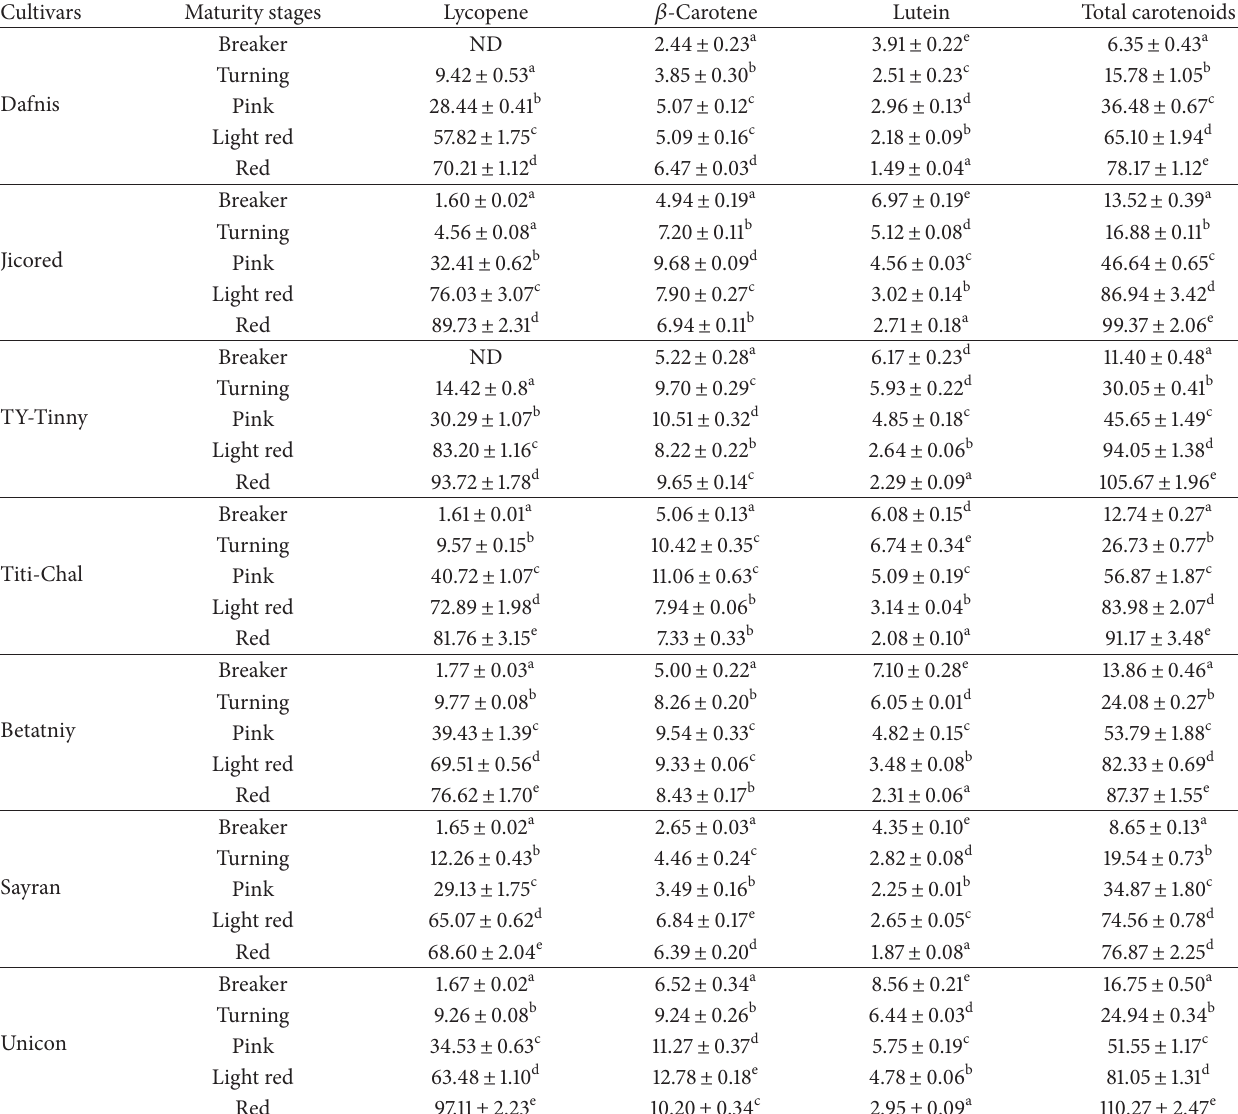
Table 2: Carotenoids content (mg/100 g, dw) in tomato fruits at different ripening